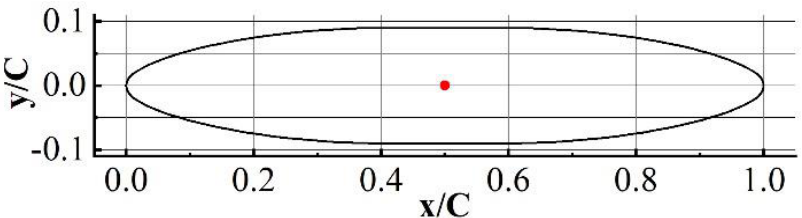
Figure 1. No-dimensional geometry of bidirectional hydrofoil, with the red point being the center point of the hydrofoil.